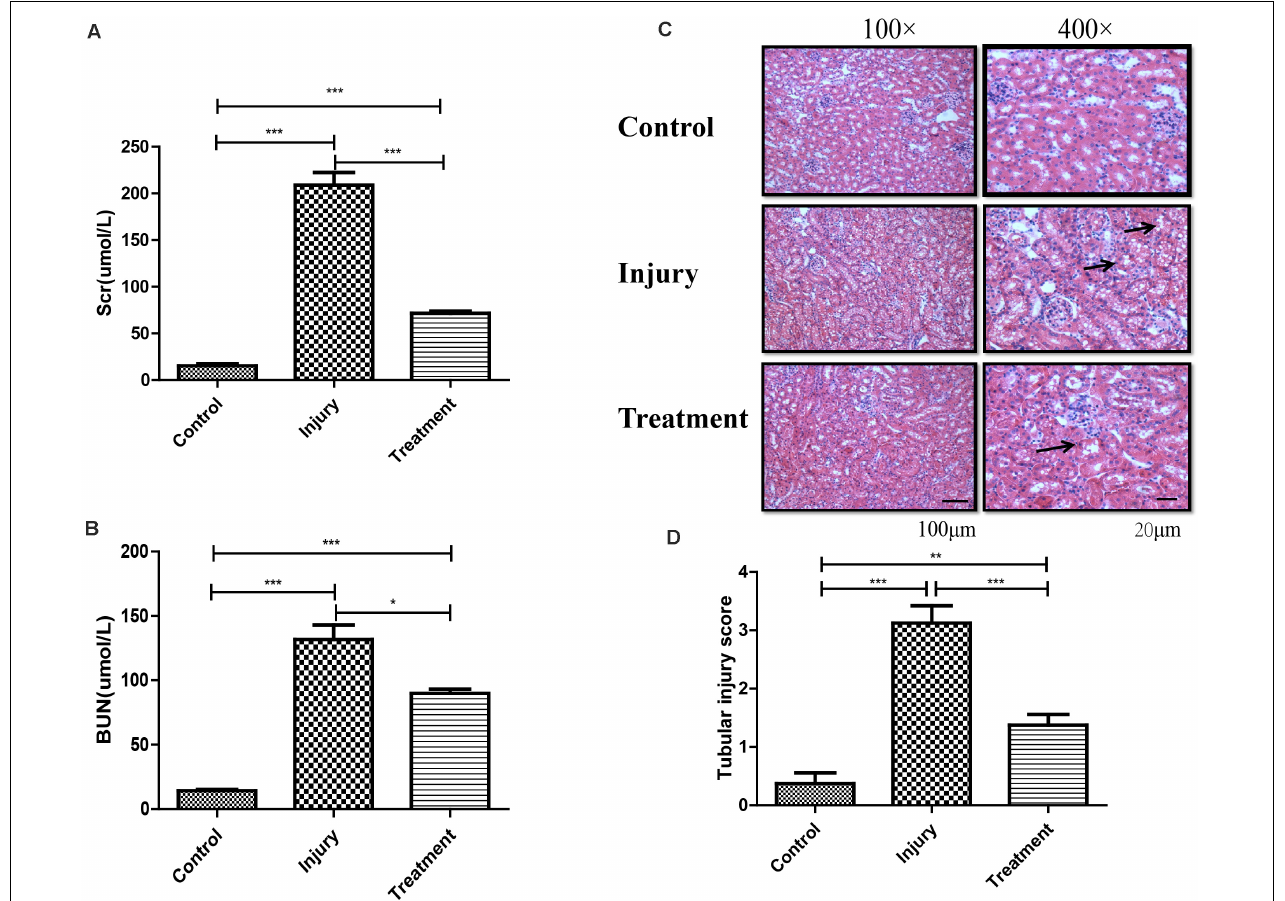
FIGURE 1 | Establishment of cisplatin-induced acute kidney injury model in C57 mouse. (A) Analysis of Scr level in mice following different treatments. Error bars represent the standard deviation. *** p < 0.001, Student’s t -test. (B) Analysis of BUN level in mice following different treatments. Error bars represent the standard deviation. * p < 0.05, *** p < 0.001, Student’s t -test. (C) Represents the image of hematoxylin and eosin staining in kidney (black arrows indicating the injury). (D) Score for characteristic histologic signs of renal injury. ** p < 0.01, *** p < 0.001, Student’s t